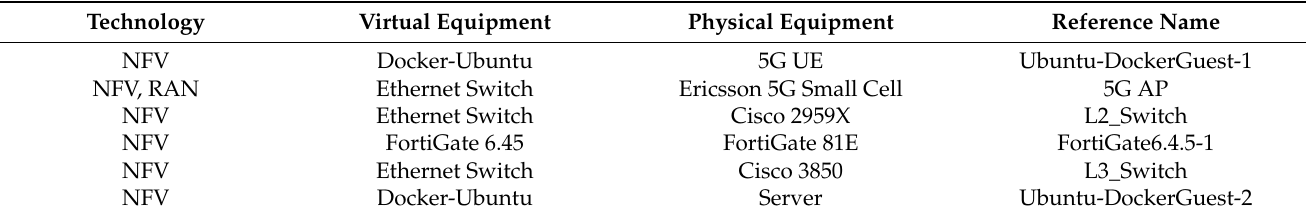
Table 9. List of network components.